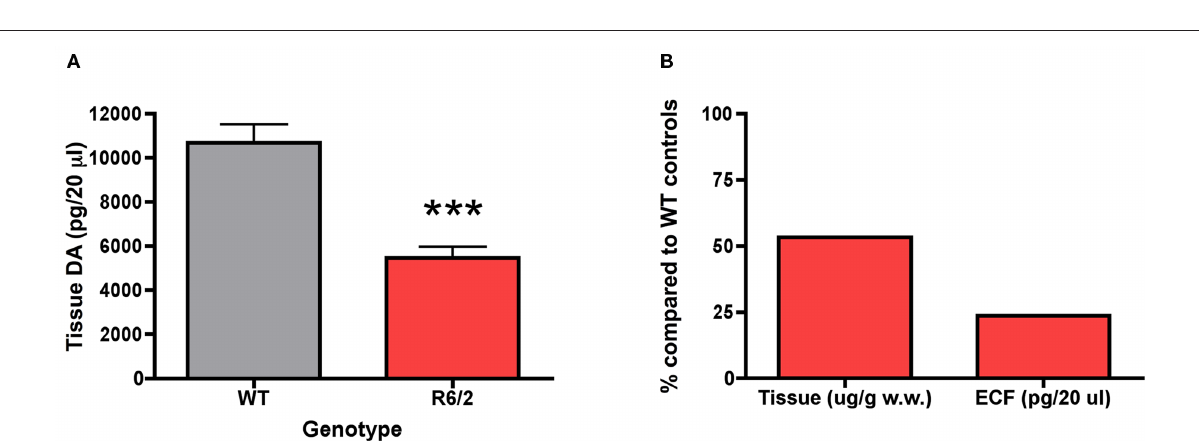
Figure 4 | Dopamine content in (A) striatal tissue of 11-week-old r6/2 transgenic mice ( n = 6 WT, 6 r6/2) and (B) comparison of the percentage of dopamine levels in relation to WT mice in tissue and the extracellular fluid (eCF). Striatal tissue dopamine content data are μg/g wet weight of tissue and striatal ECF dopamine data are picograms per 20 μl sample of dialysate. All data are mean ± SEM. *** Indicates significantly different from WT, P